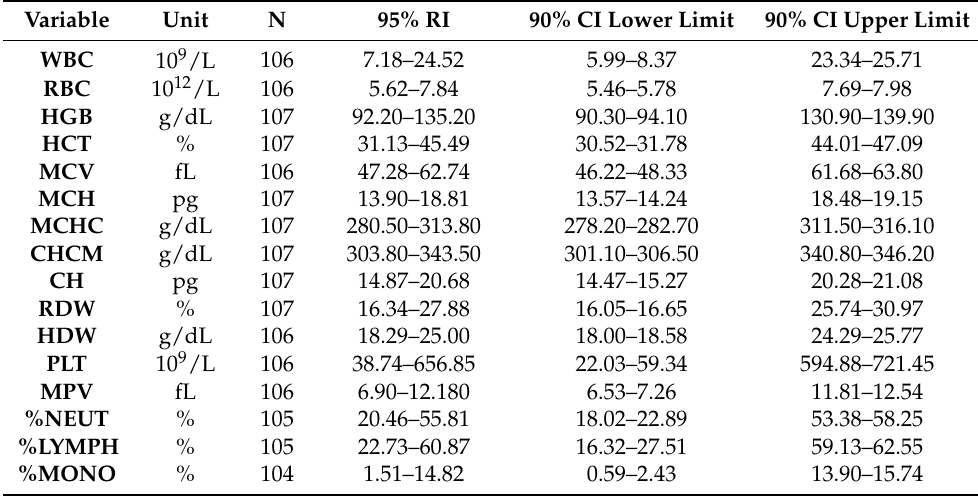
Table 3. Hematology values and RIs for nursery